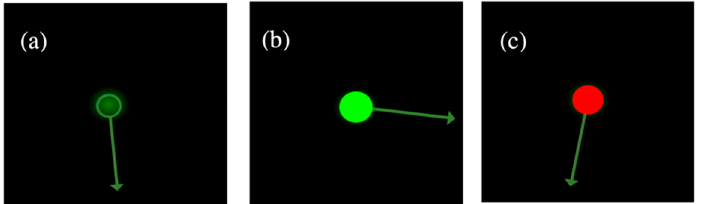
Figure 2. Different clock hand status during the attention task. ( a ) Normal clock rotation; ( b ) abnormal clock rotation, after correctly detection by user; ( c ) incorrect user response due to missed abnormal rotation or spacebar press for a normal clock rotation.